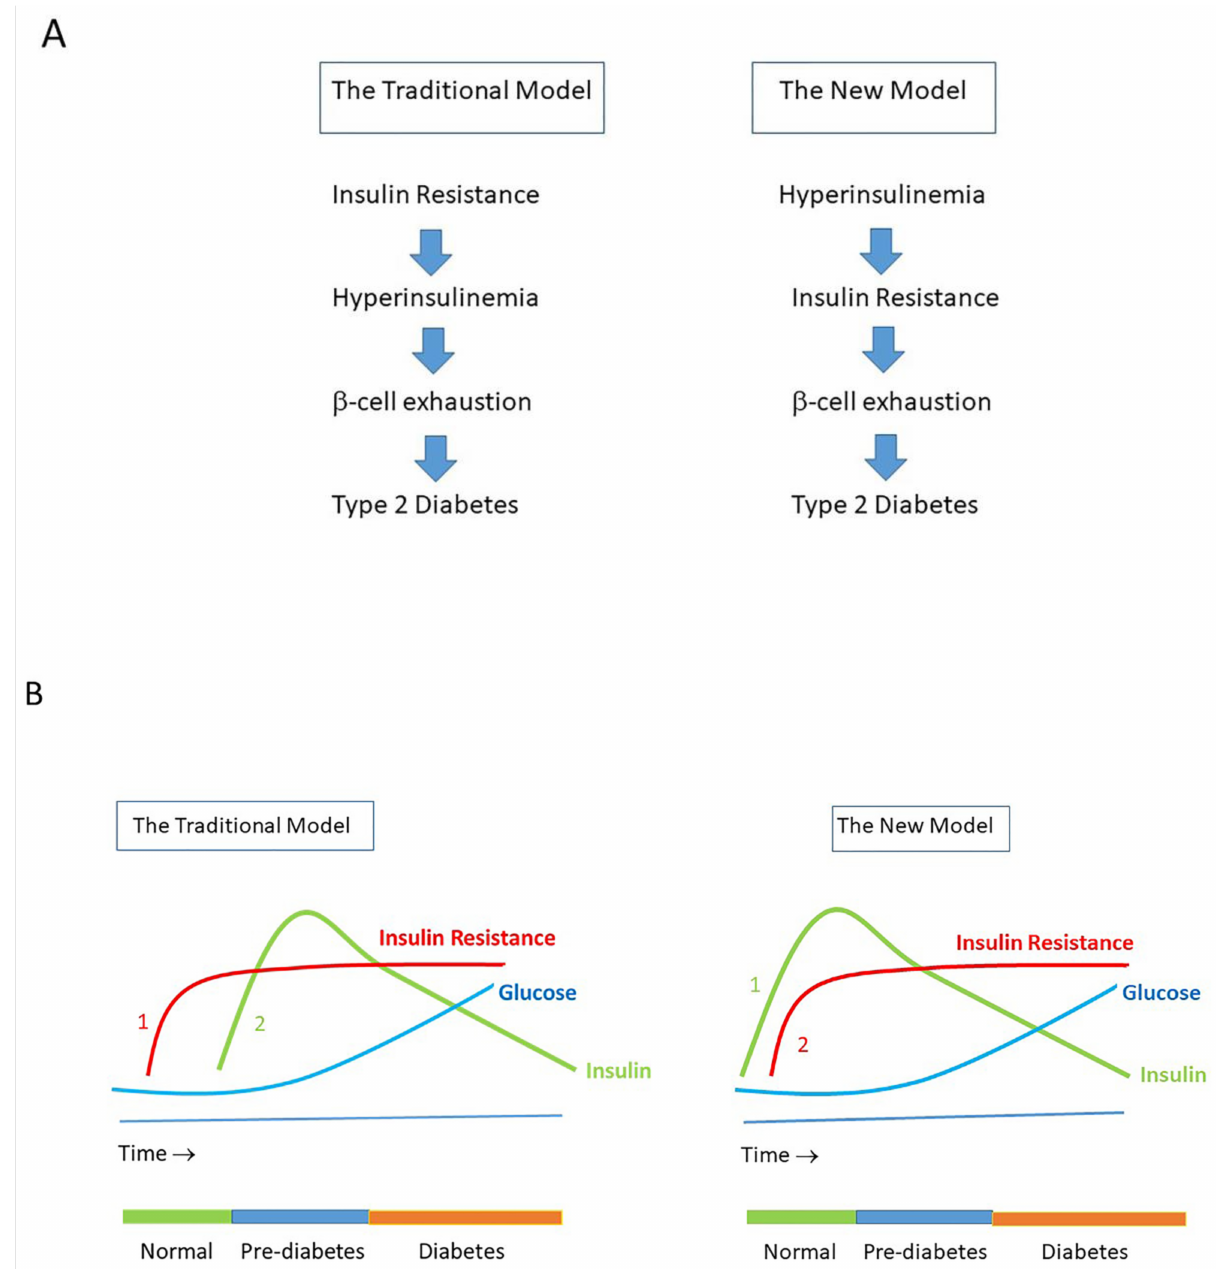
Figure 2. ( A ). The Traditional Model vs. The New Model of the pathogenesis of type 2 diabetes. The Traditional Model posits that insulin resistance is the primary abnormality leading to hyperinsulinemia, which is followed by β -cell dysfunction. When β -cells are no longer able to sustain sufficient insulin secretion to compensate hyperglycemia, they become exhausted and frank type 2 diabetes will develop. The Traditional Model has been called into question since it cannot explain that hyperinsulinemia can already be found in subjects with normal glucose tolerance (see text for details). In the (alternative) New Model, chronic hypersecretion of insulin (due to genetics and environmental factors) is the primary abnormality leading to hyperinsulinemia. Hyperinsulinemia initiates and sustains the development of insulin resistance (and obesity), until the β -cells fail and become exhausted and ultimately frank type 2 diabetes develops. ( B ) The Traditional Model vs. The New Model of the pathogenesis of type 2 diabetes. In the Traditional Model, insulin resistance (1) precedes hyperinsulinemia (2), which is followed by β -cell exhaustion and finally frank type 2 diabetes. In the New Model, hypersecretion of insulin and the resulting hyperinsulinemia (1) primarily cause insulin resistance (2), which is followed by β -cell exhaustion and finally frank type 2 diabetes. Note that in The New Model hyperinsulinemia is already present when there is a normal glucose